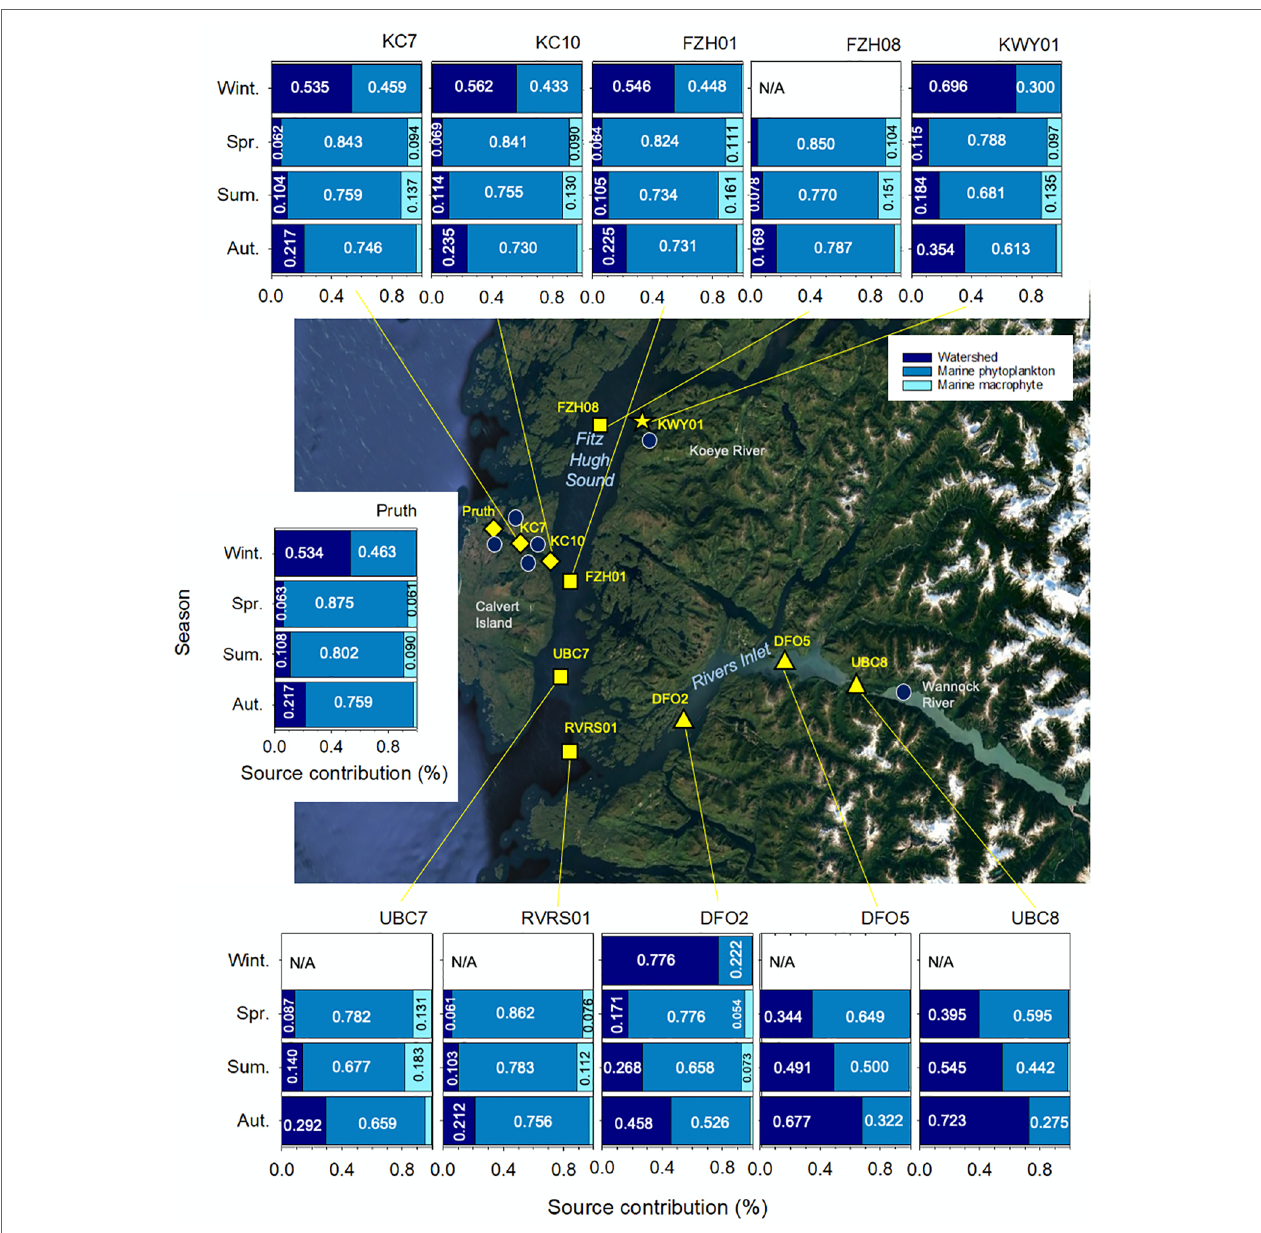
FIGURE 4 | Relative contributions of watershed, marine phytoplankton and marine macrophytes to the surface (0-10 m) water particulate organic matter pool across 11 marine stations in the coastal northeast Pacific Ocean. Median values are shown for all contributions exceeding 0.05 (5%). Winter is defined as December through February, spring is March through May, summer is June through August and autumn is September through November. Median Bayesian credible intervals are shown. 95% credible intervals are presented in Table S6 . Station symbols indicate major water bodies in the region: Rivers Inlet (triangles), Fitz Hugh Sound (squares), Kwakshua Channel (diamonds), and the Koeye Estuary (star). Centre map data: Google,